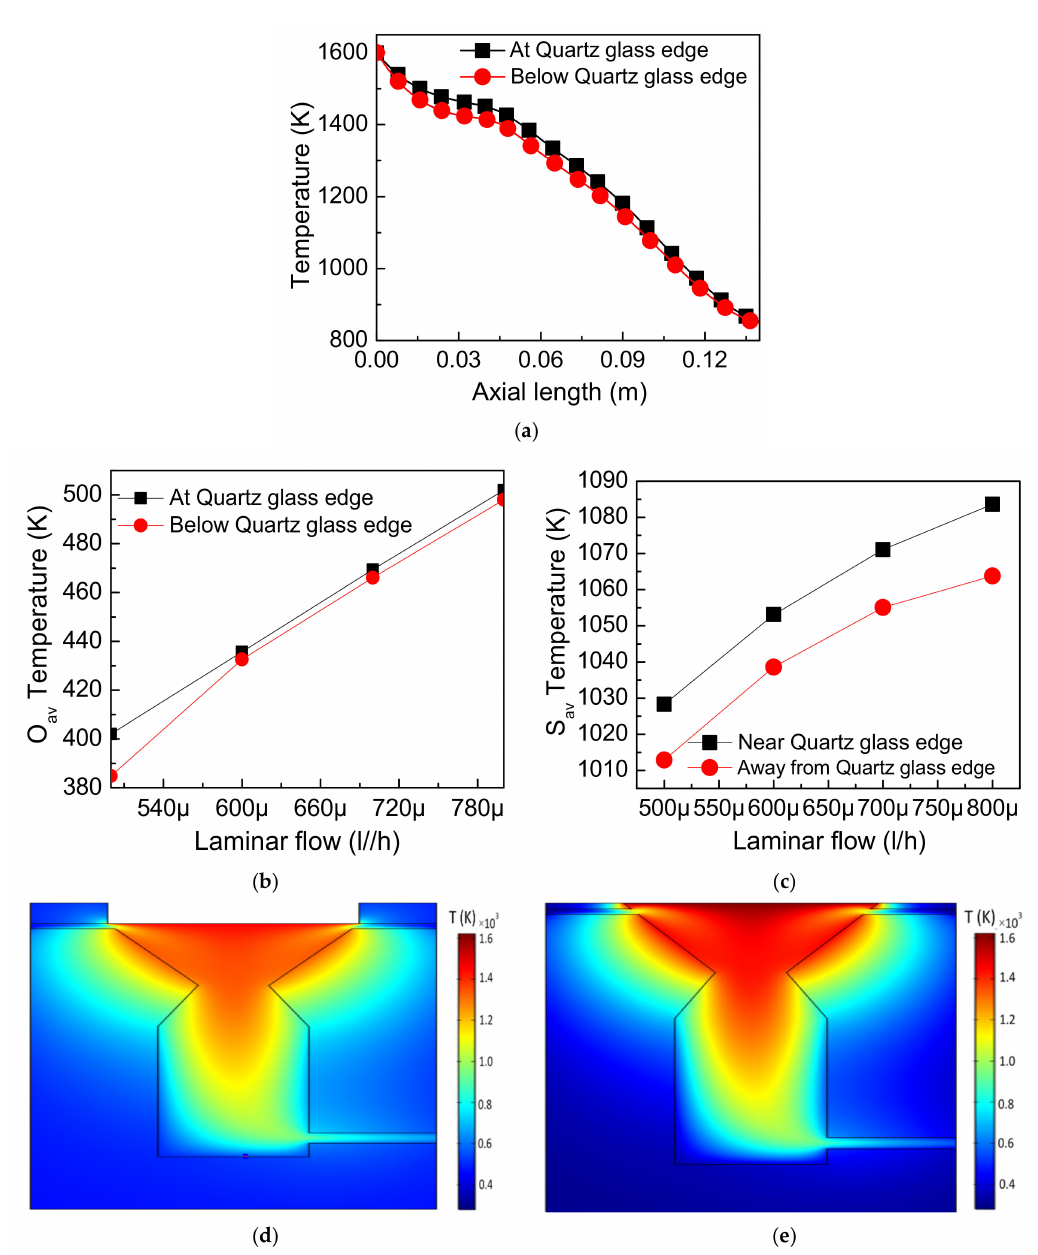
Figure 10. Temperature distribution along the axial length of inlet tubes at the edge of quartz glass and below the edge of quartz glass at 2.88 L / h flow rate and 1600 K applied at quartz edge: ( a ) Axial temperature distribution and ( b ) Side outlet average temperature; ( c ) Average surface temperature; ( d )Axialtemperaturedistributionofinletsatthequartzglassedgeand( e )Axialtemperaturedistribution of inlets below the quartz glass